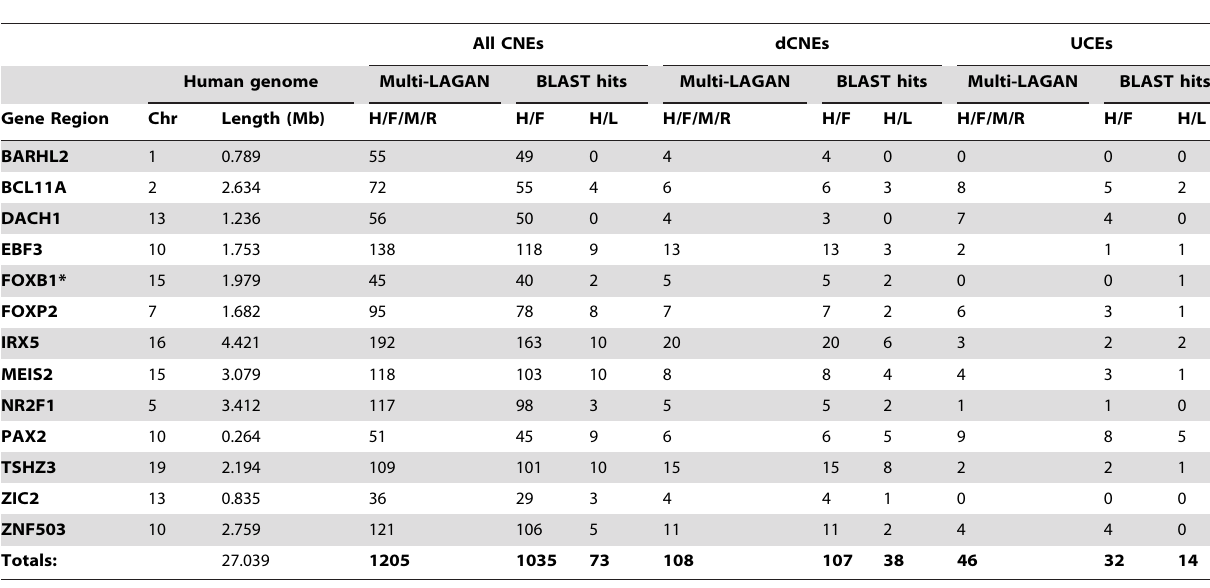
Table 1. Conserved non-coding elements from 13 human gene regions identified in the Fugu and lamprey